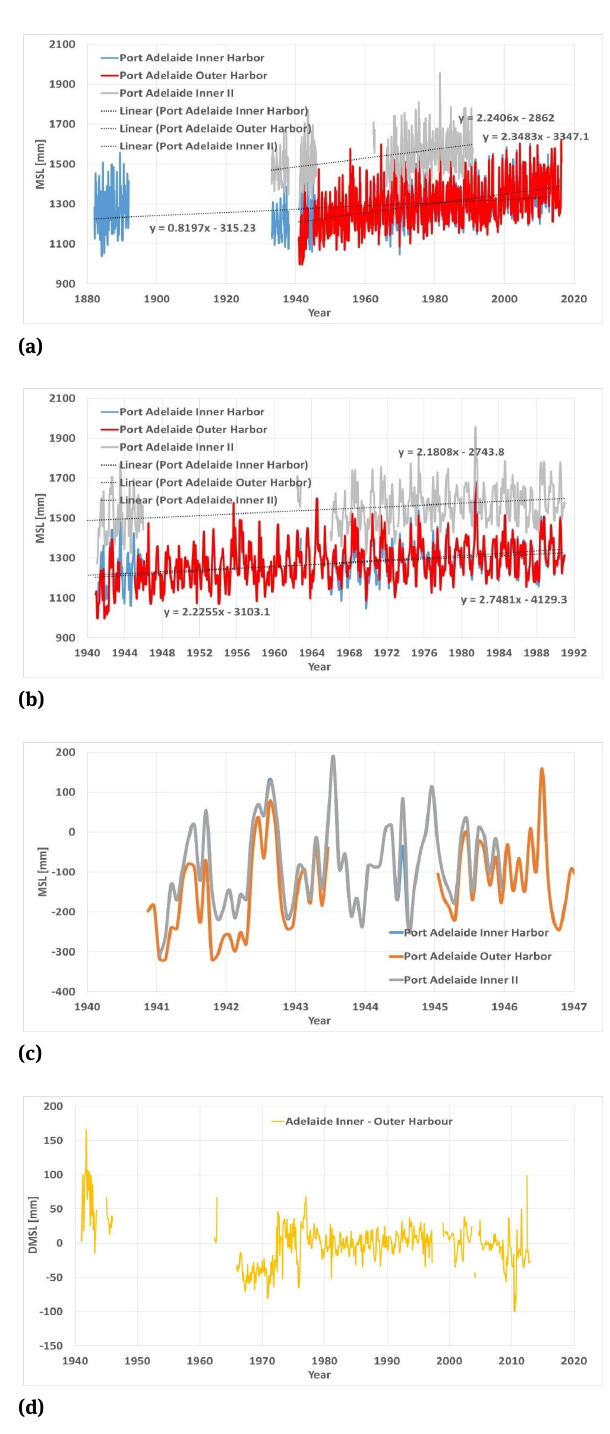
Figure 17: Relative sea level rise in Adelaide. MSL data from